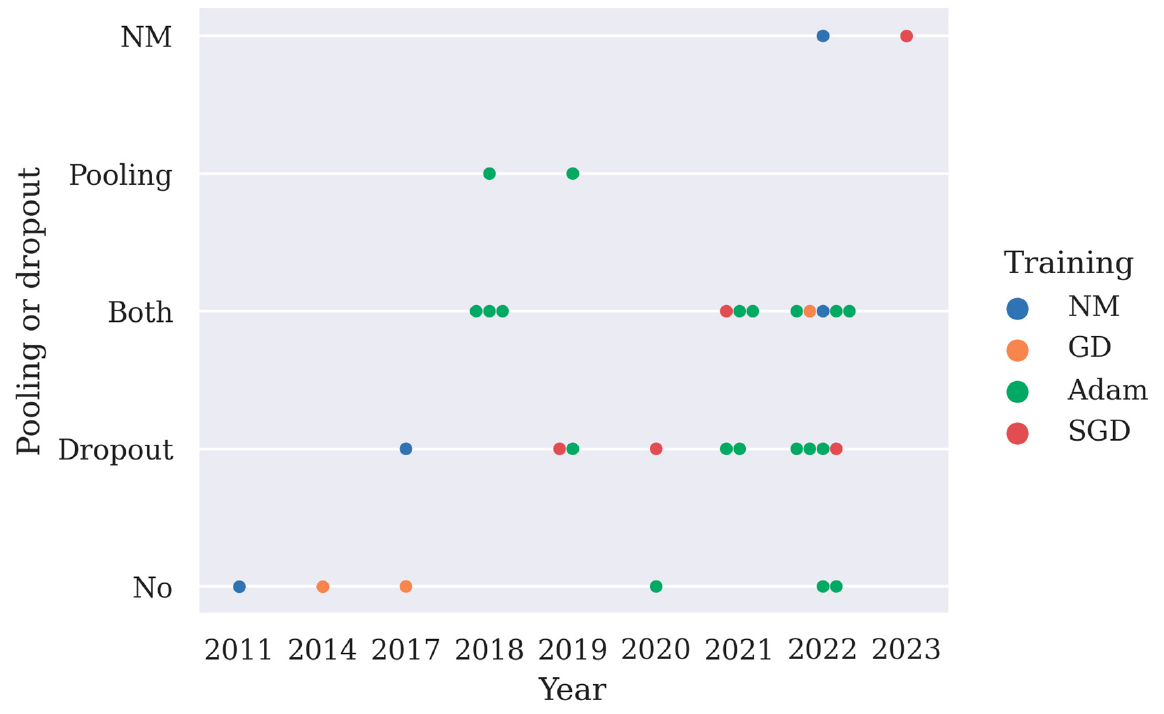
Figure 3. A summary of the implementation of pooling layers or dropout in 31 deep learning studies and their training methods, as shown in Table 2 (NM stands for not mentioned, GD stands for gradient descent, SGD stands for stochastic gradient descent with momentum, pooling is short for pooling layer) .